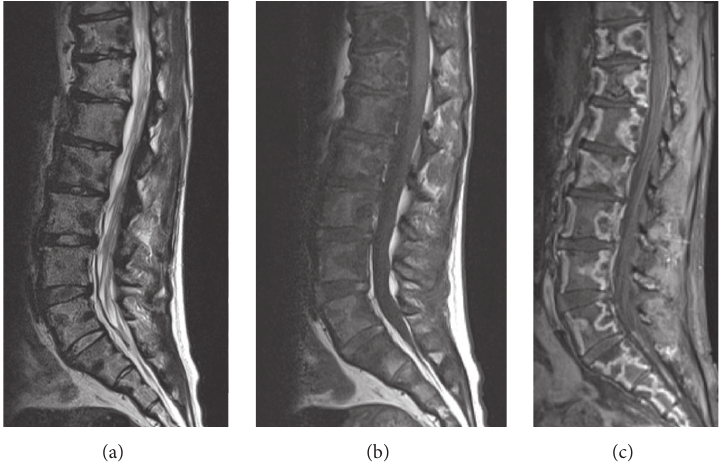
Figure 4: Lumbar spine MRI without and with contrast obtained 6 months after the initial presentation. (a) Sagittal T2 weighted and T1 weighted images without contrast and (c) sagittal postcontrast T1-weighted fat suppressed image. These images show marrow signal alteration with associated band-like areas of enhancement surrounding areas of nonenhancement with associated T1 and T2 hypointensity, consistent with diffuse